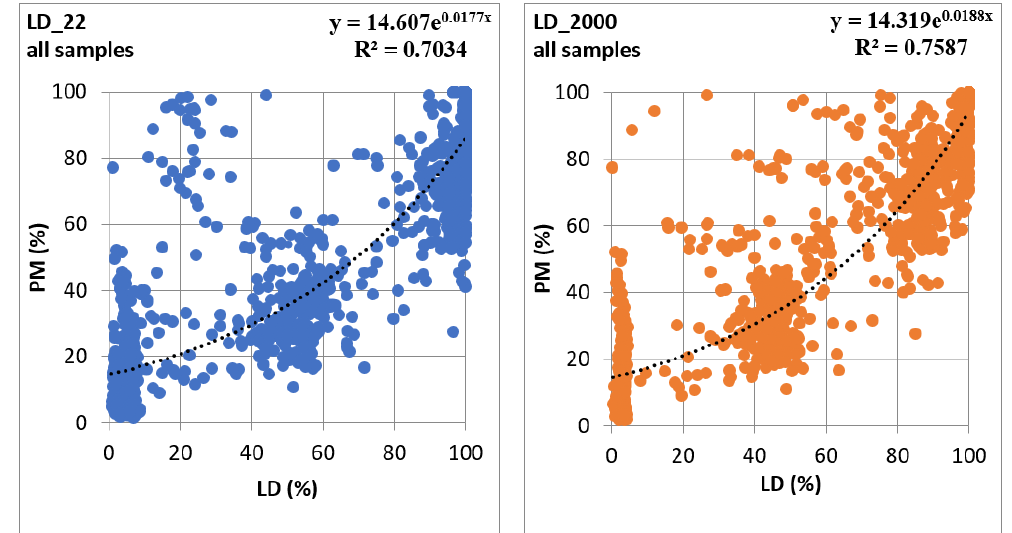
Figure 4. Exponential regression correlation between pipette method (PM) and laser diffraction method for all soil samples as determined by Analysette22 MicroTec plus (LD_22) and Mastersizer2000 (LD_2000).